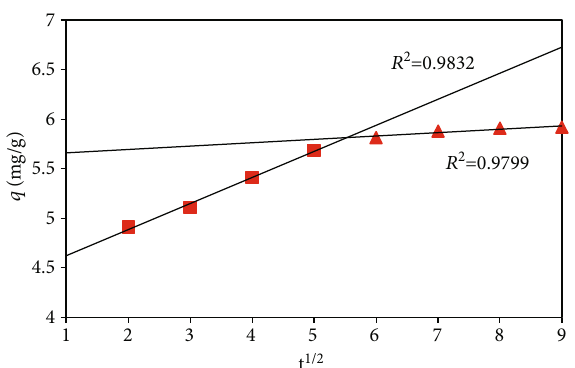
Figure 14: Plot for q vs. t 1/2 consisting of multiple straight lines for CV adsorption onto ACMAS ( T = 293K , CVconcentration = 25 mg/L , pH = 6 : 0